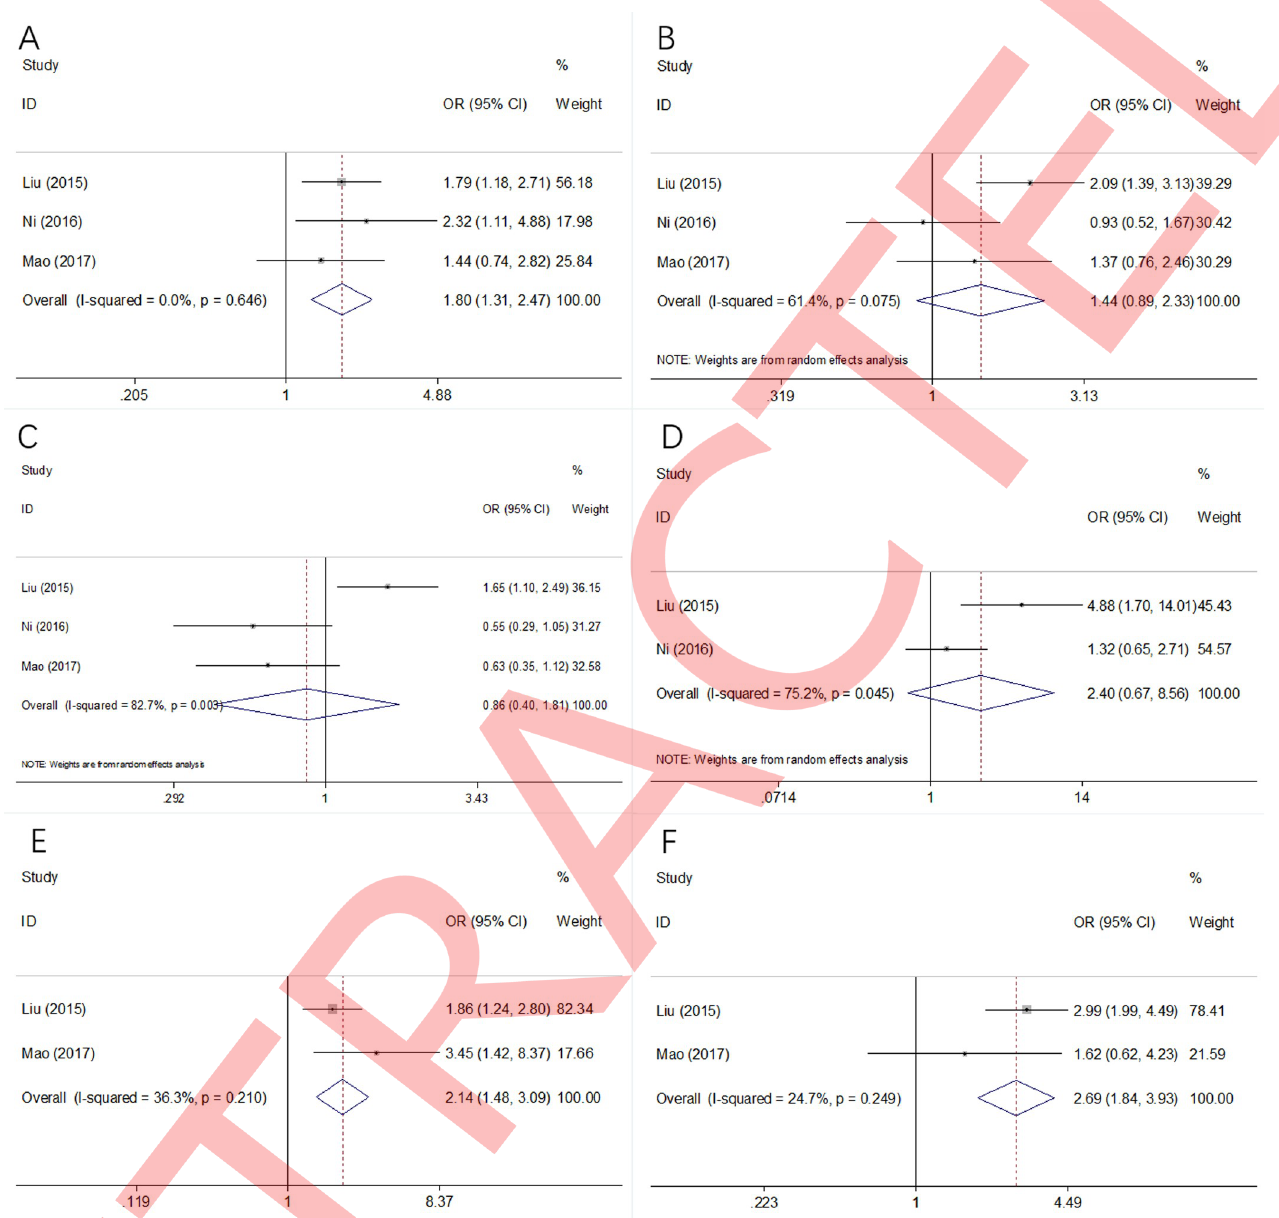
Fig 4. Association between CAR levels with clinicopathological characteristics of patients with GC. (A) Sex, (B) Age, (C) Tumor location, (D) Platelets counts, (E) TNM stage, and (F) Tumor size. https://doi.org/10.1371/journal.pone.0250295.g004 worse survival and unfavorable clinical characteristics in cancer patients [15]. Another meta- analysis on esophageal cancer (EC) also indicates that high pretreatment CAR is an adverse prognostic factor for EC patients, based on data of 8 studies with 2255 patients [39]. A recent meta-analysis comprising 9 studies also demonstrates that elevated pretreatment CAR is asso- ciated with poor OS and disease-free survival (DFS)/relapse-free survival (RFS) in colorectal cancer (CRC). In addition, high CAR is also correlated with several clinical features in patients with CRC [20]. In the present meta-analysis, we showed the prognostic impact of CAR and its